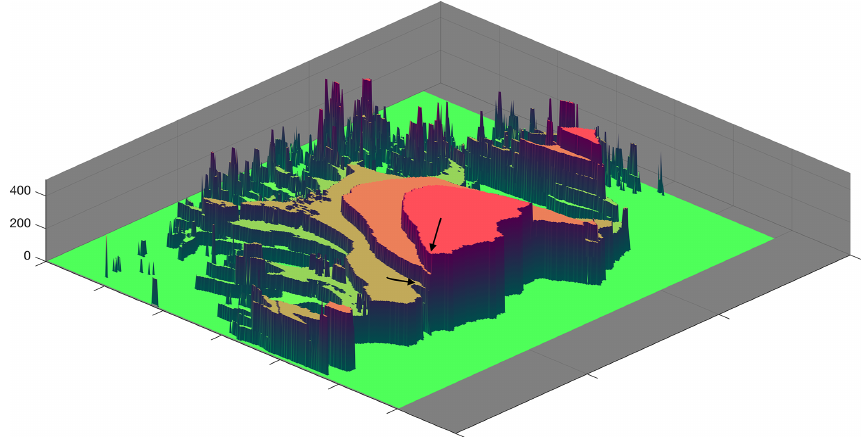
Figure B1. Directed affinity partitions, with the mean velocity (speed) of the partition assigned for each label entry. The spatial distance between the arrow tips is less than 2 miles (3.22km), while the difference in the speed is more than 200m/yr.